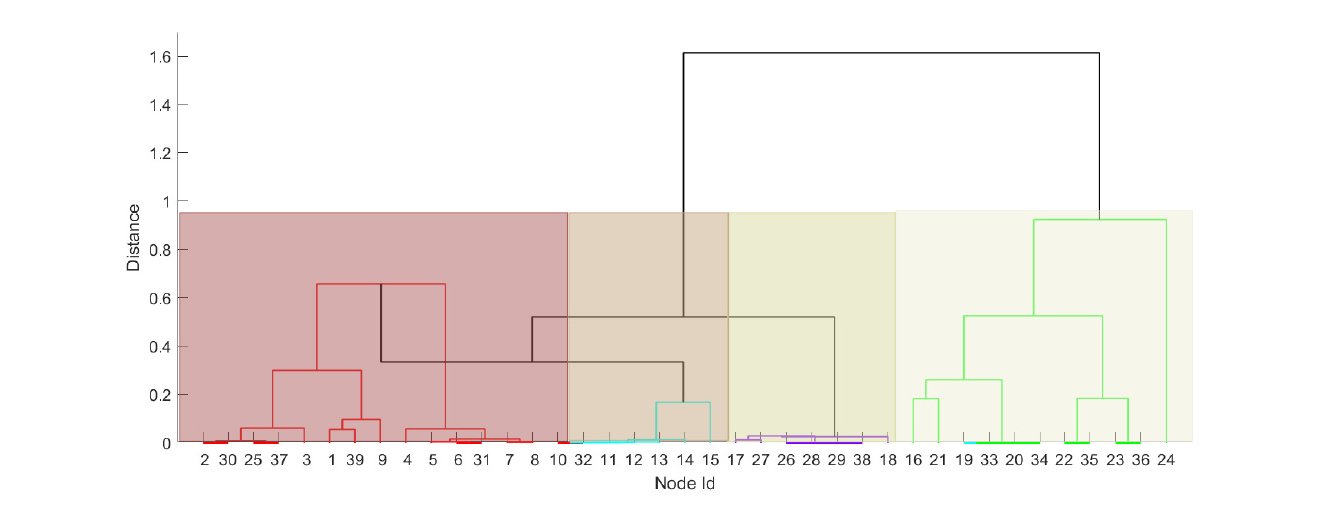
Figure 6. Comparison of the dendrograms obtained without ( a ) and with ( b ) control area constraints. Colours in figure ( b ) represent dendrograms obtained for each control area. The bidding zones delimitations are visualized in the two-column Figure 7: the left column shows the output of the algorithm which did not preserve control area constraints, and the right column with. The rows represent divisions into 2 (top), 3 (middle) and 6 (bottom) bidding zones, with the bidding zones being marked by different node